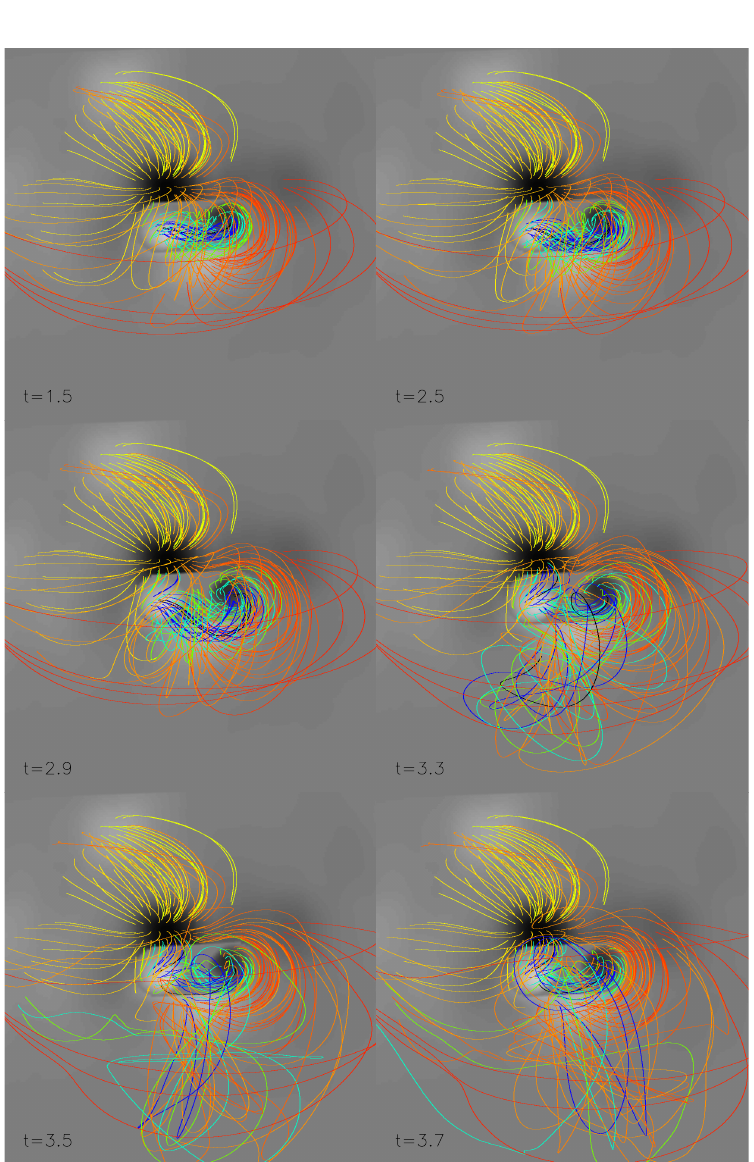
Figure 63: Still from a movie showing 3D rendering from a simulation of an eruption following emergence of a twisted flux tube into a pre-existing sunspot. This is an idealized scenario to mimic the evolution of NOAA AR 10930, which produced an X3.4 flare with an Earth-directed CME. Observations of AR 10930 showed the formation of a delta spot following emergence of a parasitic bipolar region. Reproduced with permission from Fan (2011), copyright by AAS. (To watch the movie, please go to the online version